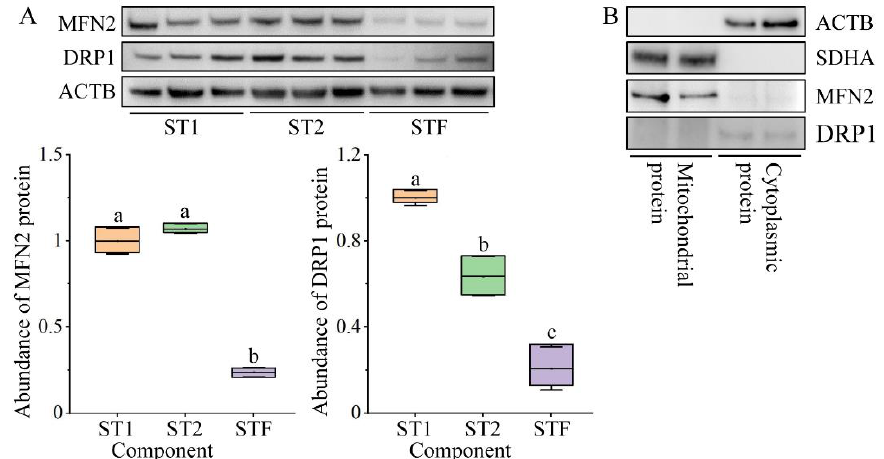
Figure 5. Expression of MFN2 and DRP1 in different components of coelomic fluid and their subcellular localization in early spermatid. ( A ) Expression of MFN2 and DRP1 in different components of coelomic fluid. The different letters above columns indicate significant differences ( p < 0.05). ST1 and ST2: components consisting of many spermatids; STF: spermatid-free components. ( B ) Distribution of MFN2 and DRP1 in spermatid mitochondria and cytoplasm from which mitochondria were removed.